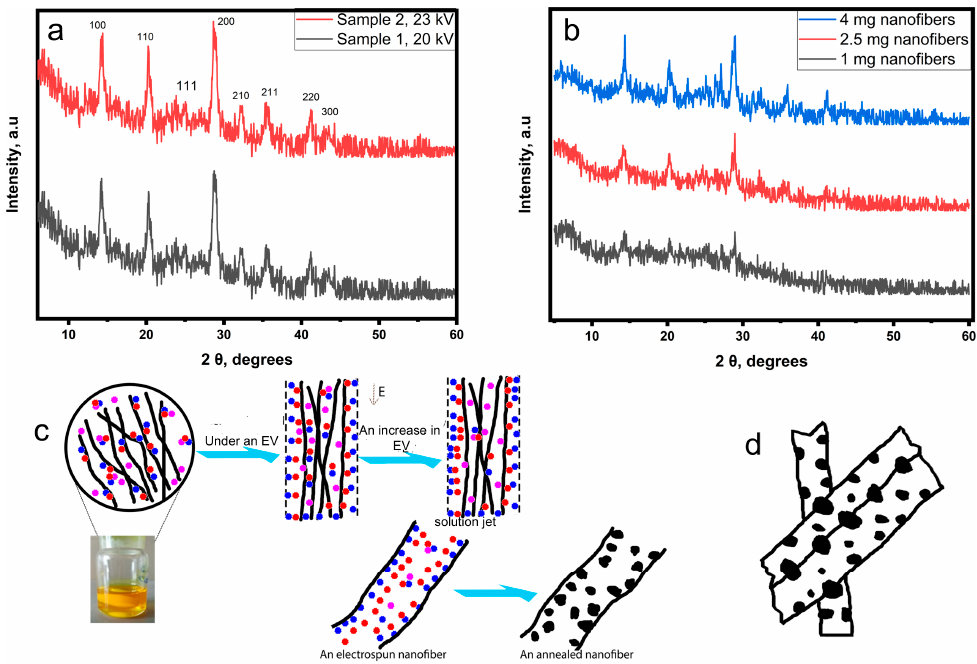
Figure 4. Perovskite crystallinity: ( a ) XRD patterns of samples 1 and 2, fabricated at electrical voltage values 20 kV and 23 kV, respectively (electrospinning parameters: voltage: 20–23 kV, distance: 150 mm, needle diameter: 0.42 mm, feed rate: 0.1 mL/h, planar collector); ( b ) XRD patterns of various nanofibers amounts on the glass (1, 2.5, 4 mg) (electrospinning parameters: voltage: 20 kV, distance: 150 mm, needle diameter: 0.42 mm, feed rate: 0.1 mL/h, planar collector); ( c ) a schematic illustration shows the influence of the electrical voltage on the crystallinity of perovskite; ( d ) a schematic representation of the longitudinal section of nanofibers shows the potential formation of some crystals on the combined surfaces between nanofibers.